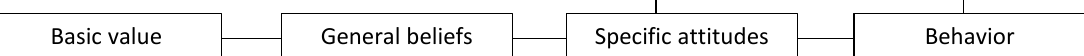
Basic Figure 1. Demonstration of a hierarchical model on values, beliefs, attitudes and behavior